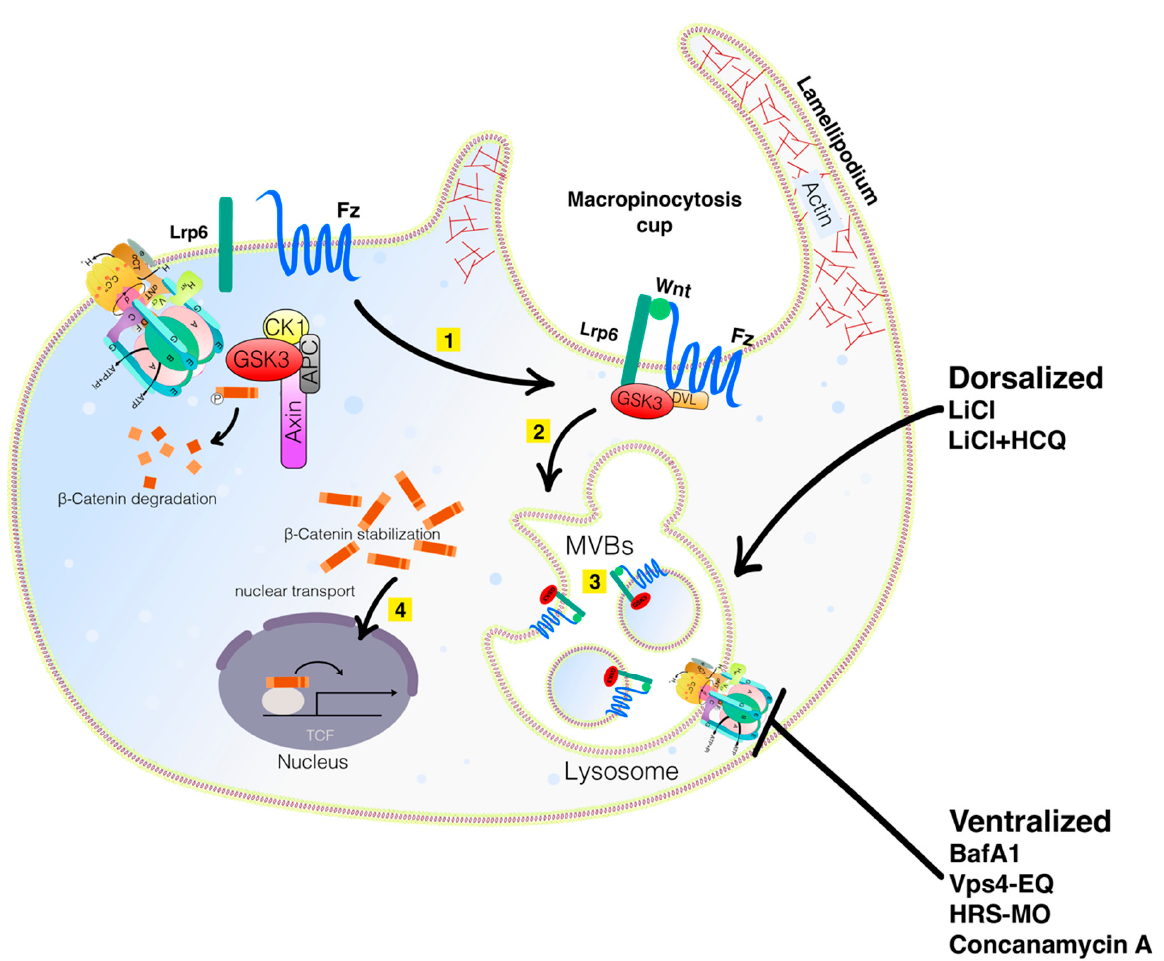
Figure 2. Wnt signaling involves macropinocytosis, V-ATPase, MVBs, membrane trafficking, and lysosomes. Sequestration of GSK3 is a vital step in the activation of the canonical Wnt pathway. When the Wnt ligands bind to the Fz receptor and the Lrp6 co-receptors (Step 1 in yellow), GSK3 is translocated into the membrane. It is then internalized into an early endosome and subsequently into MVBs (Step 2). The sequestration of GSK3 and the destruction complex activate the Wnt pathway (Step 3). Lysosomal activity is critical for dorsal development. Mimicking Wnt signaling with LiCl can dorsalize embryos, an effect that is even more pronounced with LiCl plus HCQ. Inhibiting lysosomal activity with BafA1 or Concanamycin A or interfering with the MVB formation with VPS4-EQ or HRS-MO ventralizes embryos. Wnt and cell adhesion are often active in the same processes and crosstalk between them exists by reciprocal regulation and sharing of components. Knowing how Wnt signaling and cell adhesion cooperate will improve our understanding of embryonic development decisions and carcinomas. Diagram based on findings reported in Tejeda—Muñoz et al., 2022, with permission from Proceeding of the National Academy of Science and Creative